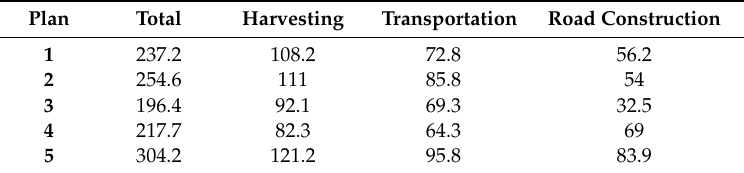
Table 2. Main cost categories (million